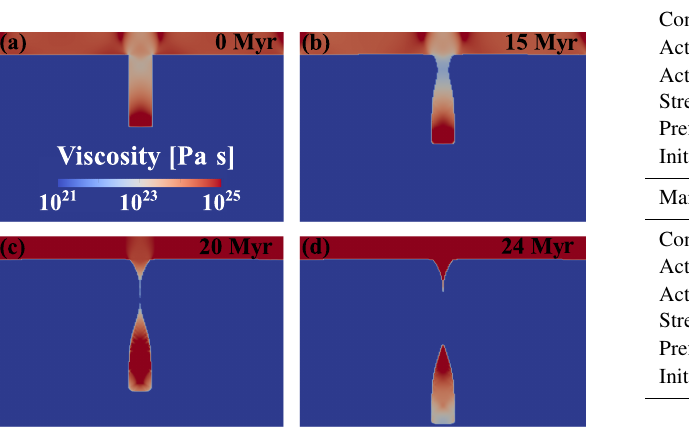
Figure 11. The detachment benchmark model setup of Schmal- holz (2011): a symmetric system of nonlinear viscous lithosphere (Eq. 19) with a vertical slab extending into a linear viscous man- tle. The top and bottom boundaries are free slip, while the vertical boundaries are no slip. Along the outline of the slab are placed 20 passive tracers to track the necking of the slab.